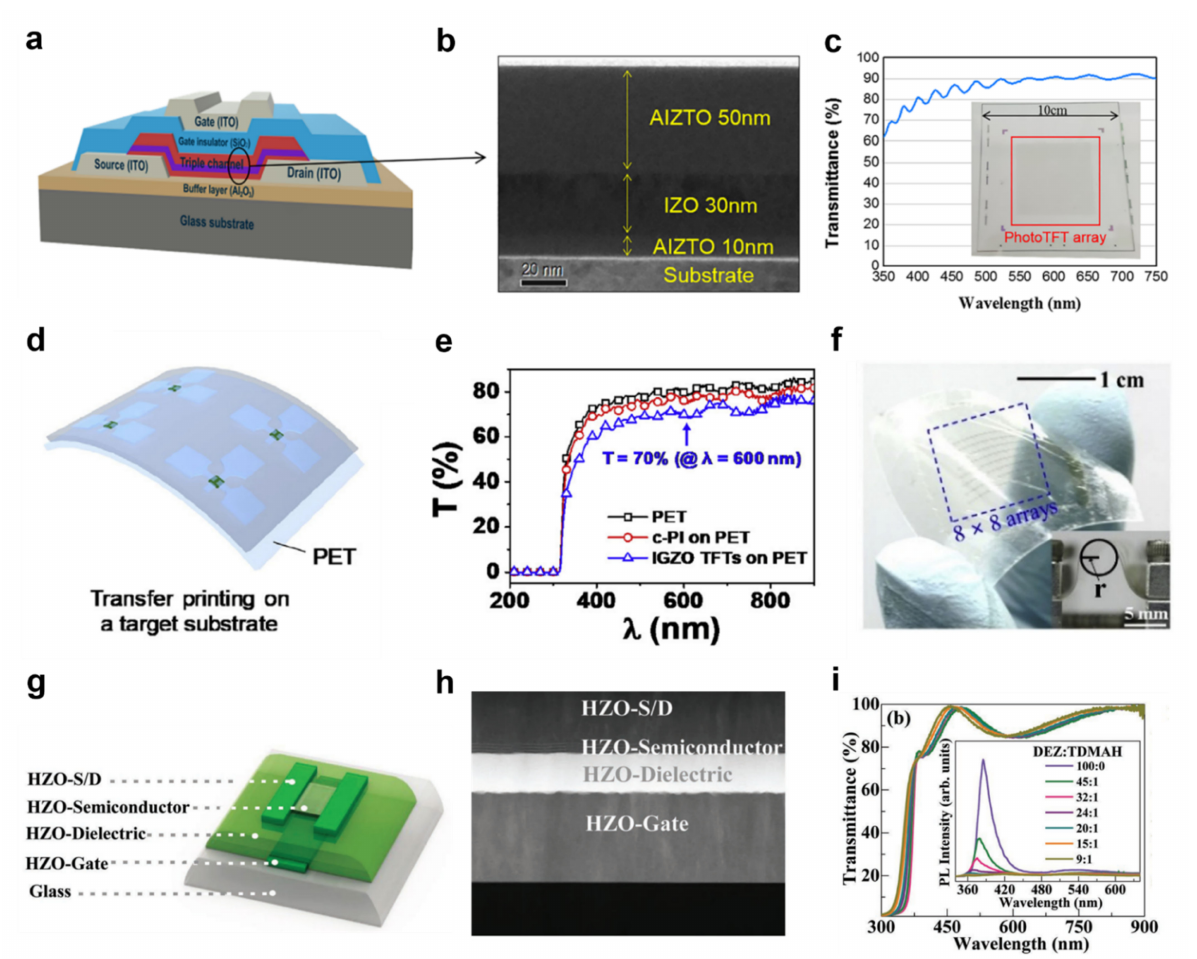
Figure 4. ( a ) Schematic diagram of an AlZTO/IZO/ALZTO TFT; ( b ) Cross-section TEM image of the channel layer; ( c ) Transmittance of a phototransistor array with 300 pixels per inch (adapted from [69] with permission from the American Institute of Physics); ( d ) Schematic diagram of a transparent and flexible device; ( e ) Transmittance of DUV photodetector fabricated on the PET and CPI substrate; ( f ) 8 × 8 IGZO TFT array fabricated on a PET substrate. The inset shows bending the device in tensile mode, where r is a bending radius (adapted from [73] with permission from the Elsevier B.V.); ( g ) Schematic diagram of an HZO-based TFT; ( h ) Cross-section TEM image of HZO-based TFT; ( i ) Transmittance of the conducting HZO film (adapted from [74] with permission from the John Wiley and